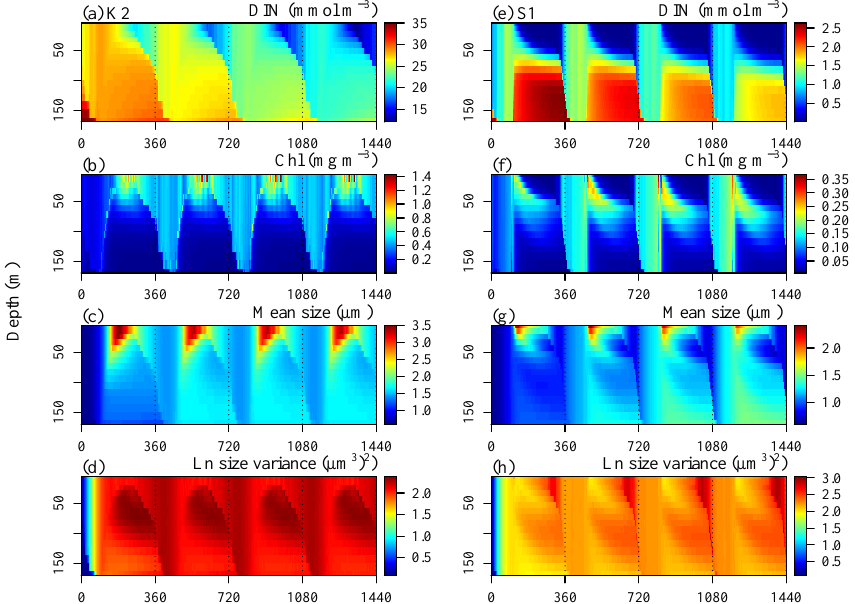
Figure 3. An example of modeled patterns of total inorganic nitrogen (DIN), Chl a (Chl), mean size, and ln size variance for 4 years at stations K2 (a–d) and S1 (e–h)